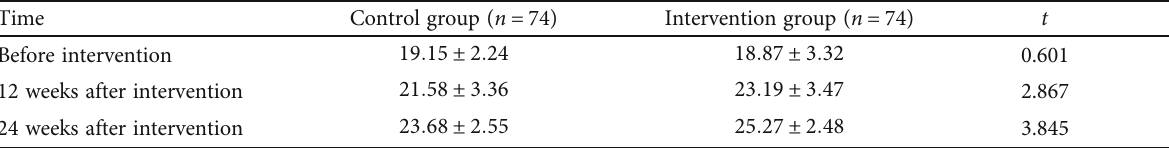
Table 4: Score of medication compliance scale between the two groups (point, (cid:1) x ± s ).